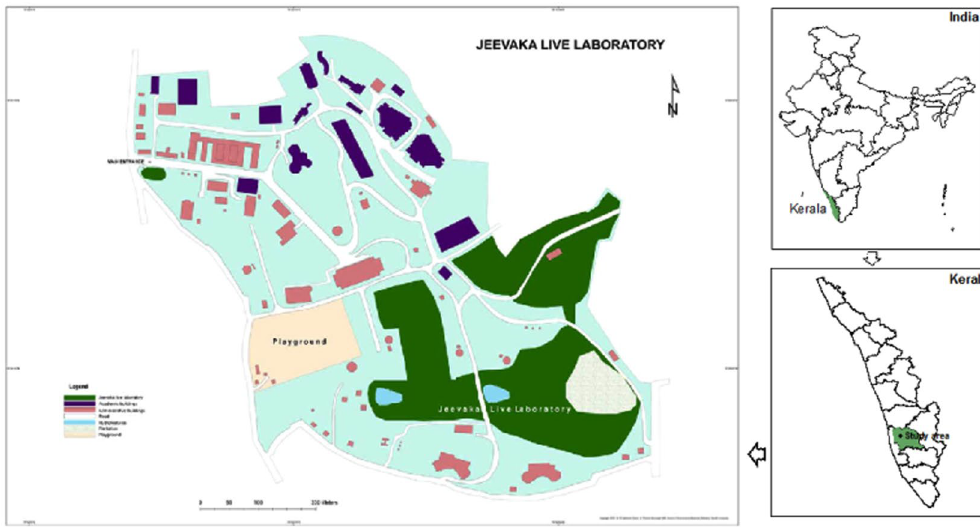
Figure 1. Map showing the study area-Jeevaka live laboratory (Q GIS Version 2.18.14 -new LTR; https://www.